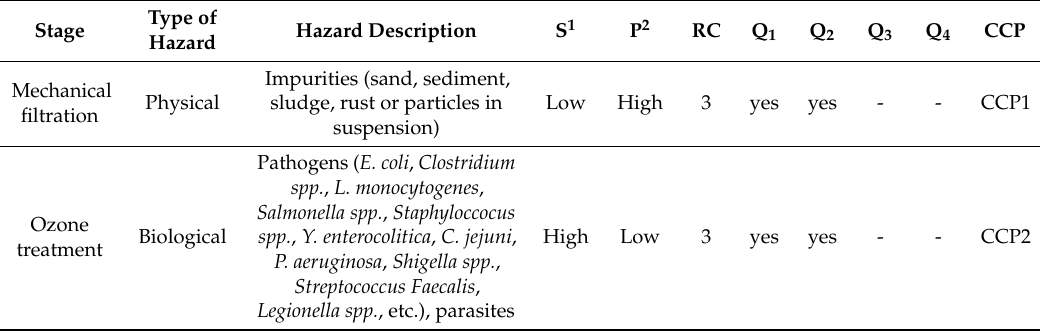
Table 11. The analysis and evaluation of the hazards corresponding to the established PCCs for still